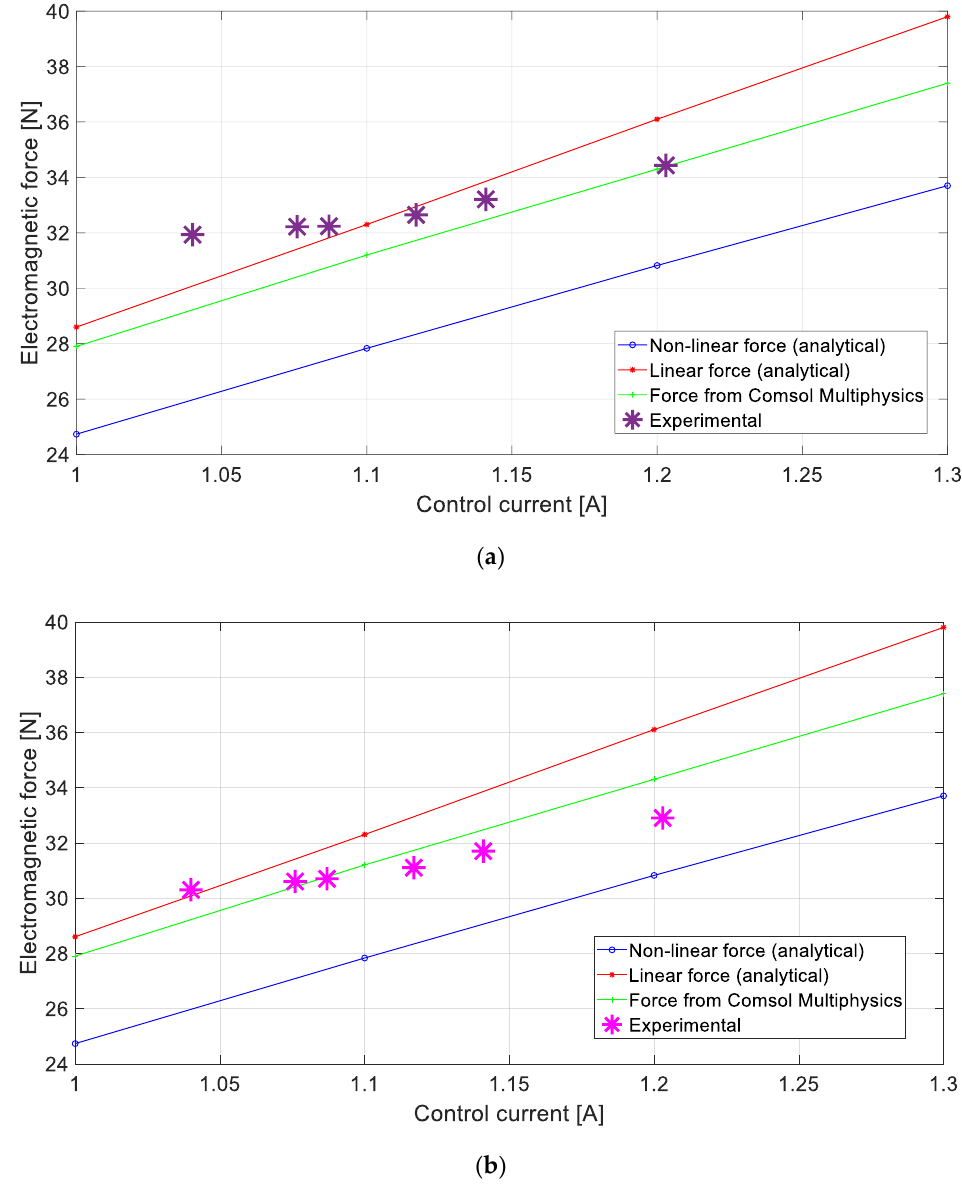
Figure 22. The resultant electromagnetic forces generated by the magnetic bearing for different values of the control current for the constant rotor – shaft raceway displacement equal to − 0.04 mm with experimental results: coefficients k x and k i obtained analytically ( a ); coefficients k x and k i determined with the use of Comsol Multiphysics software ( b ). Table 5. The resultant electromagnetic forces generated by the magnetic bearing for different control current values for the constant rotor – shaft raceway displacement equal to −0 .04 mm and coefficients kx and ki were obtained analytically (a) ; the resultant electromagnetic forces generated by the mag- netic bearing for different values of the control current for the constant rotor – shaft raceway dis- placement e qual to −0.04 mm , where coefficients k x and k i were obtained using Control Multiphys- ics software (b) .